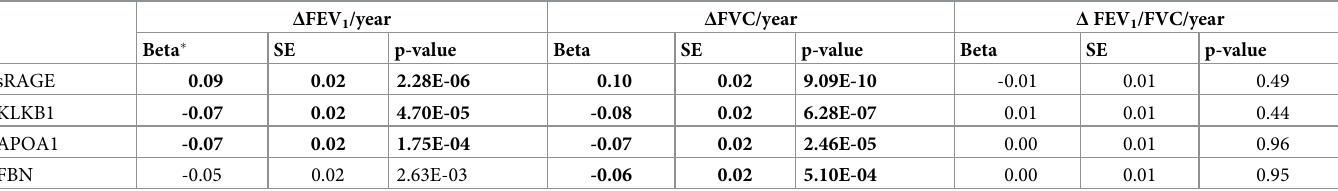
Table 4. Proteins associated with annual change in FEV 1%predicted , FVC %predicted , and/or FEV 1